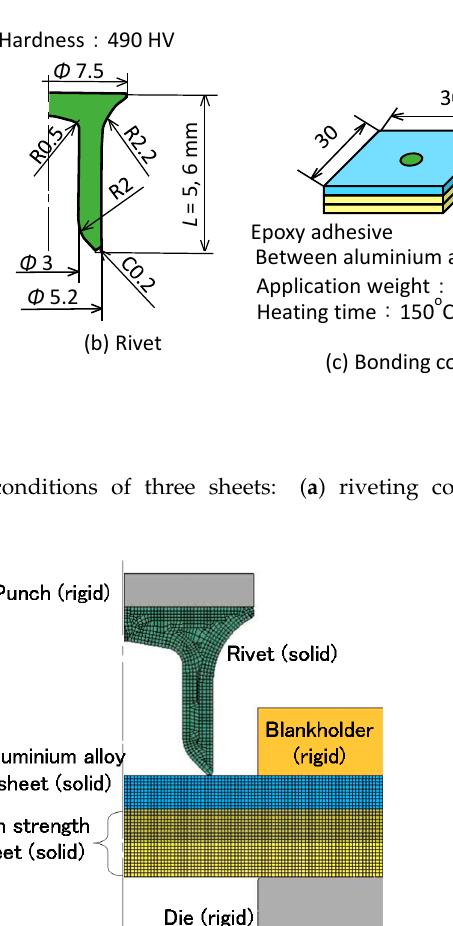
Figure 4. Self-pierce riveting conditions of three sheets: ( a ) riveting conditions; ( b ) rivet; ( c ) bonding conditions.